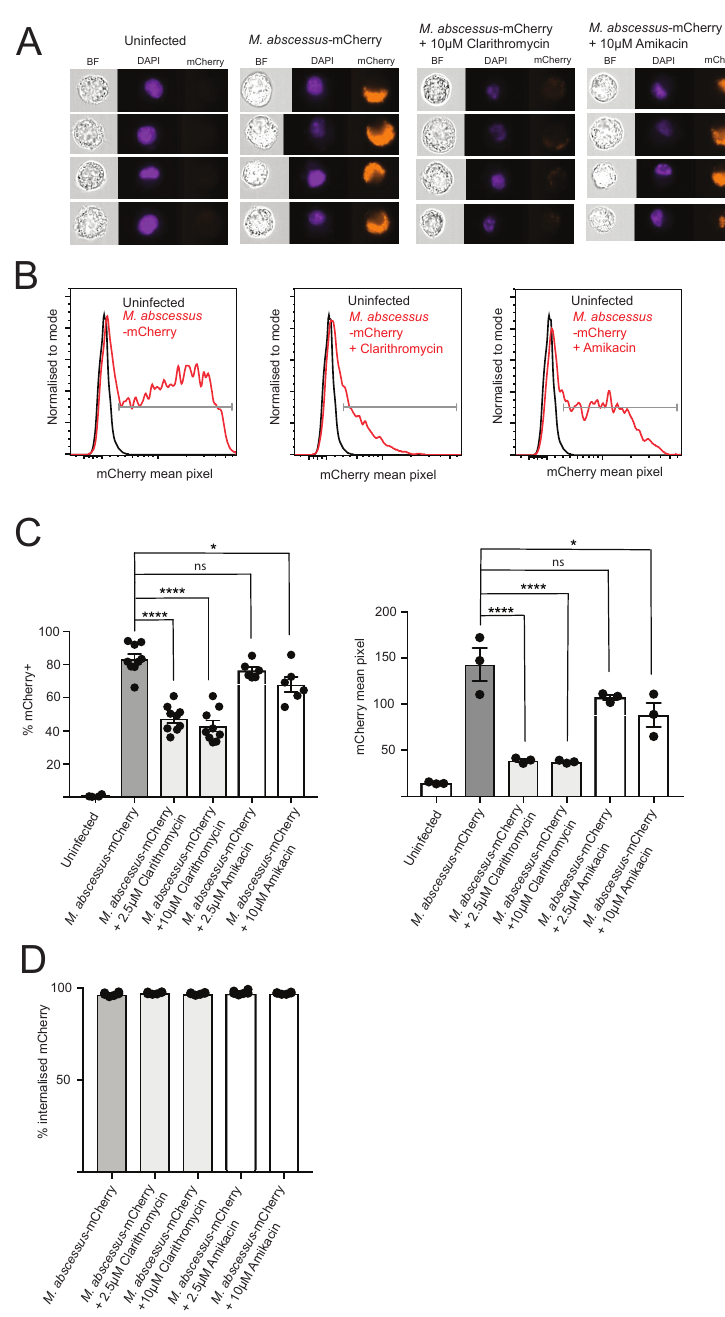
Figure 2. Single cell analysis of M. abscessus + mCherry infection and drug susceptibility using imaging flow cytometry. J774 macrophages were infected with M. abscessus + mCherry for 4 h, followed by 24 h culture with or without the indicated antibiotics for 24 h. ( A ) Representative images showing brightfield image, nuclear (DAPI) stain and mCherry image. ( B ) Representative plots of mCherry mean pixel fluorescence. ( C ) % of mCherry + cells and mCherry mean pixel fluorescence on the mCherry + population. ( D ) % of mCherry + cells with internalized mCherry signal. Data from 3 independent experiments (% mCherry + untreated and clarithromycin-treated samples), 2% mCherry + amikacin-treatedsamples)and1experiment(mCherrymeanpixel, thisisrepresentativeof3experiments for clarithromycin-treated samples, and 2 experiments with amikacin-treated samples), with 3 technical repeats per experiment. One-way ANOVA with Tukey’s multiple comparisons test was used for statistical analysis. ns = p > 0.05, * = p ≤ 0.05, **** = p ≤